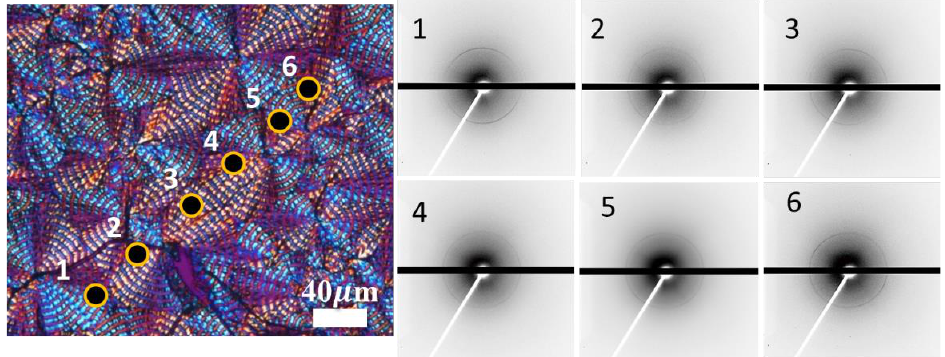
Figure 8. POM graph from PBA/PEO (90/10) at 30 °C marked with various microbeam exposure spots and corresponding 2D-WAXD patterns.